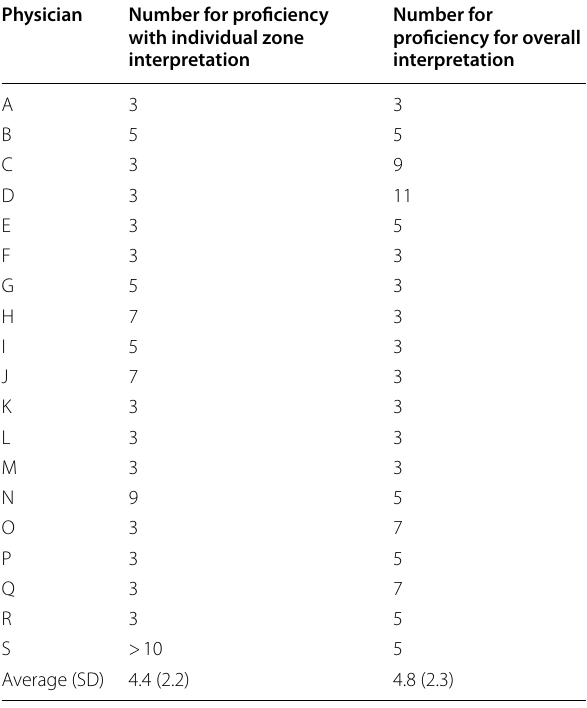
Number for proficiency for